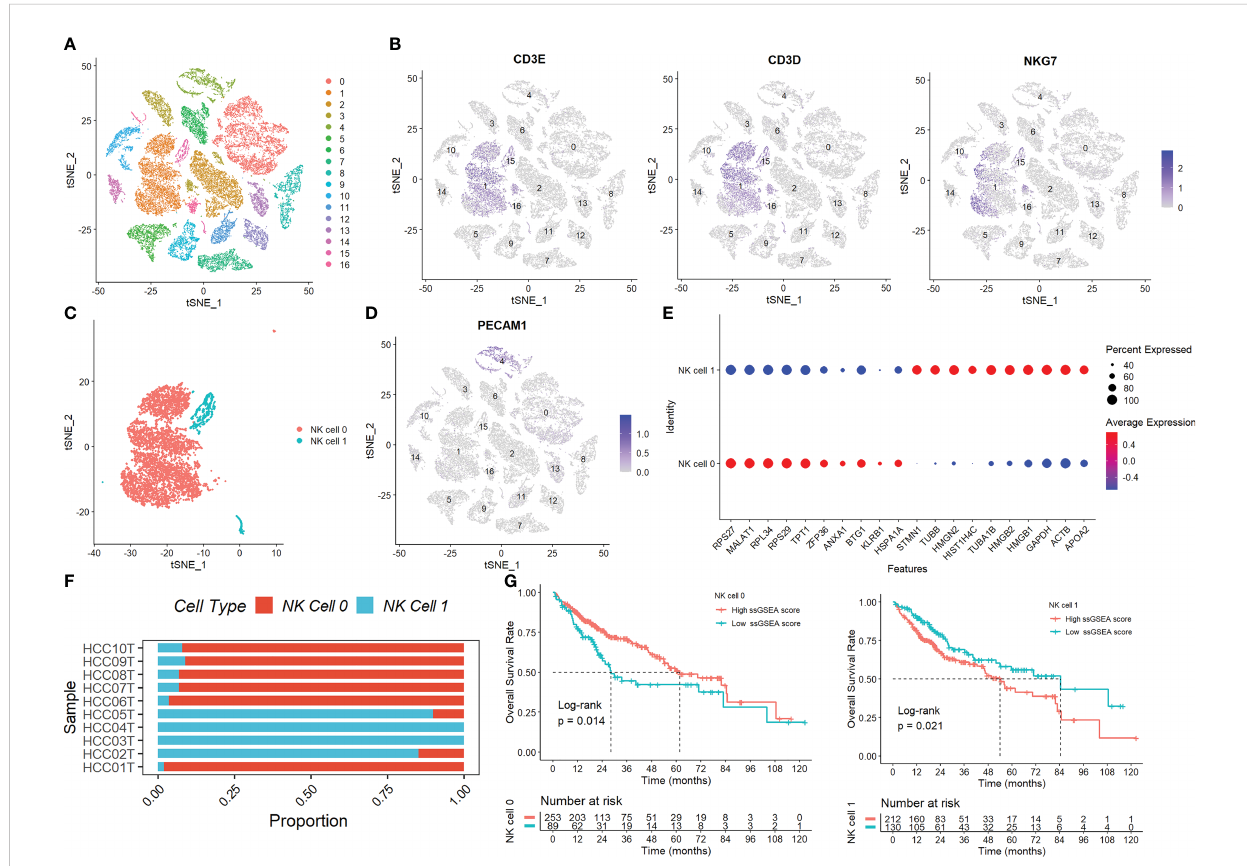
FIGURE 1 Identi fi cation of NK cells in the scRNA-seq samples. (A) The TSNE plots showed the distribution of the 17 clusters. (B) The expression of three marker genes (CD3D, CD3E, and NKG7) in the 17 clusters. (C) Two NK cell subsets were discovered. (D) The expression of PECAM1 gene. (E) The expression of the top 10 DEGs in the two clusters. (F) The percentage of the two clusters in each sample. (G) The samples in the high ssGSEA score group in the NK 0 cluster had a better prognosis than those in the low ssGSEA score group, while the opposite fi nding was seen in the NK 1